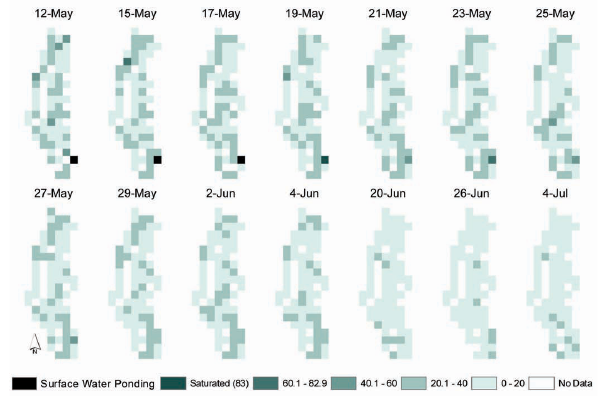
Fig. 4. Shallow soil moisture patterns at the valley site. All values are in % and survey grids are mapped at a resolution of 2m by 2m.